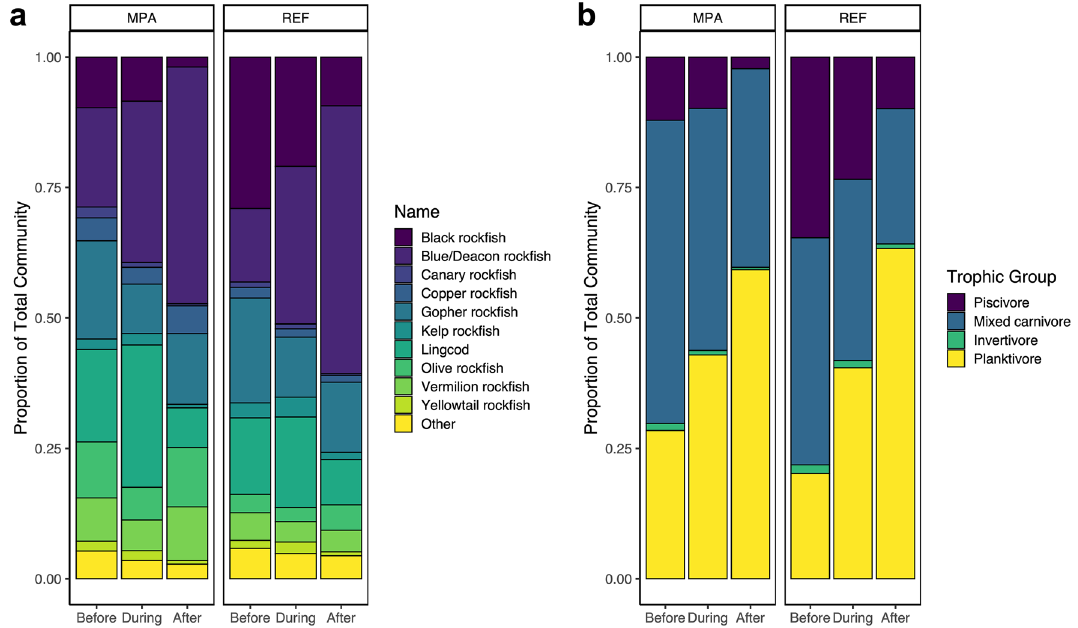
Figure 3. Changes in the ( a ) species community composition and ( b ) trophic structure at MPA and reference (REF) sites before (2007–2013), during (2014–2016) and after (2017–2020) the marine heatwave. In panel a, the top ten most abundant species are listed and all other species are grouped into the “Other”